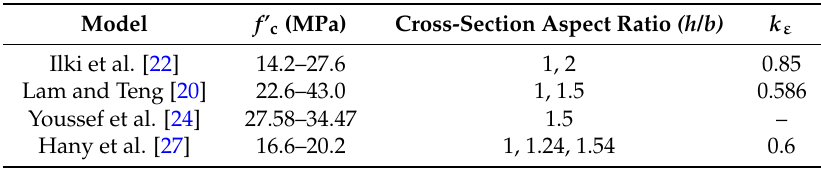
Table 5. Concrete quality and cross-section aspect ratio ranges used for the establishment of the models and FRP efficiency ratios.